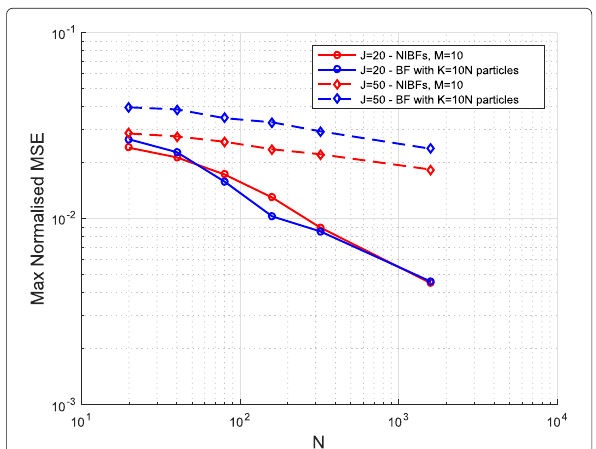
Fig. 4 Empirical maximum (out of 100 independent simulations runs) of the normalised MSE for the centralised BF, with K = 10 N particles, and the average of M = 10 NIBFs with N = 20,40,80,160,320,1600. Results are shown for a Lorenz 96 system with J = 20 variables (solid lines) and a Lorenz 96 model with J = 50 variables (dashed